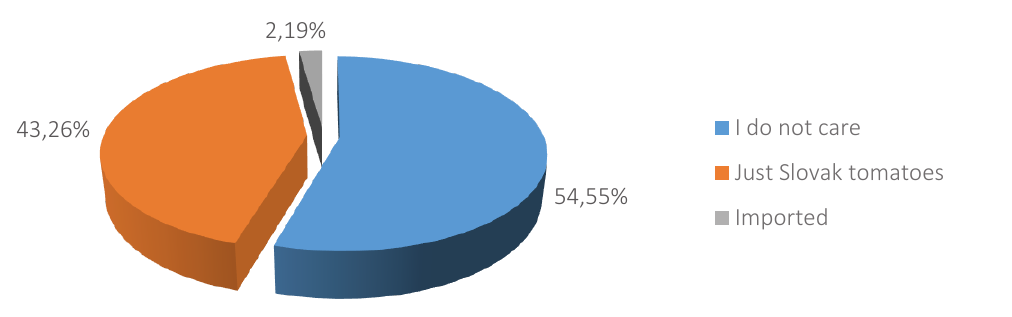
Figure 6. Preferences of tomatoes according to the country of origin by generation Z